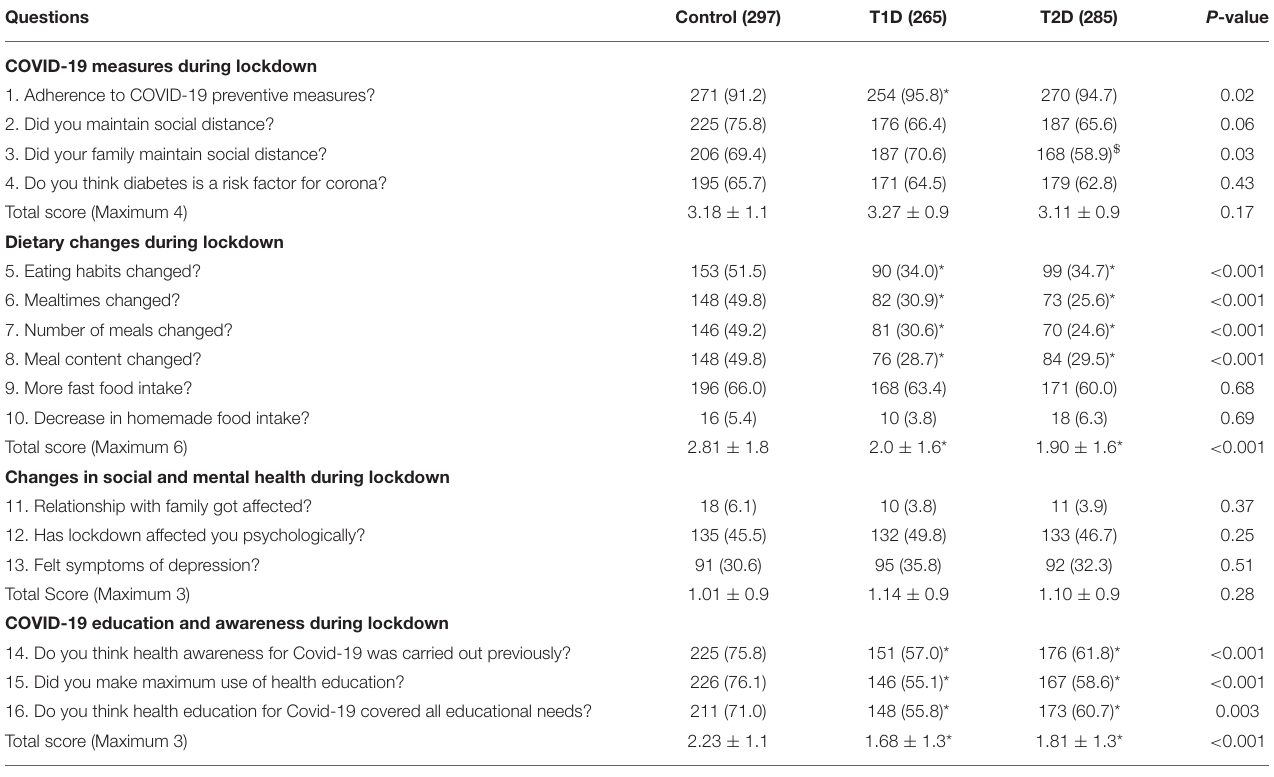
TABLE 3 | Differences in the levels of agreement according to COVID-19